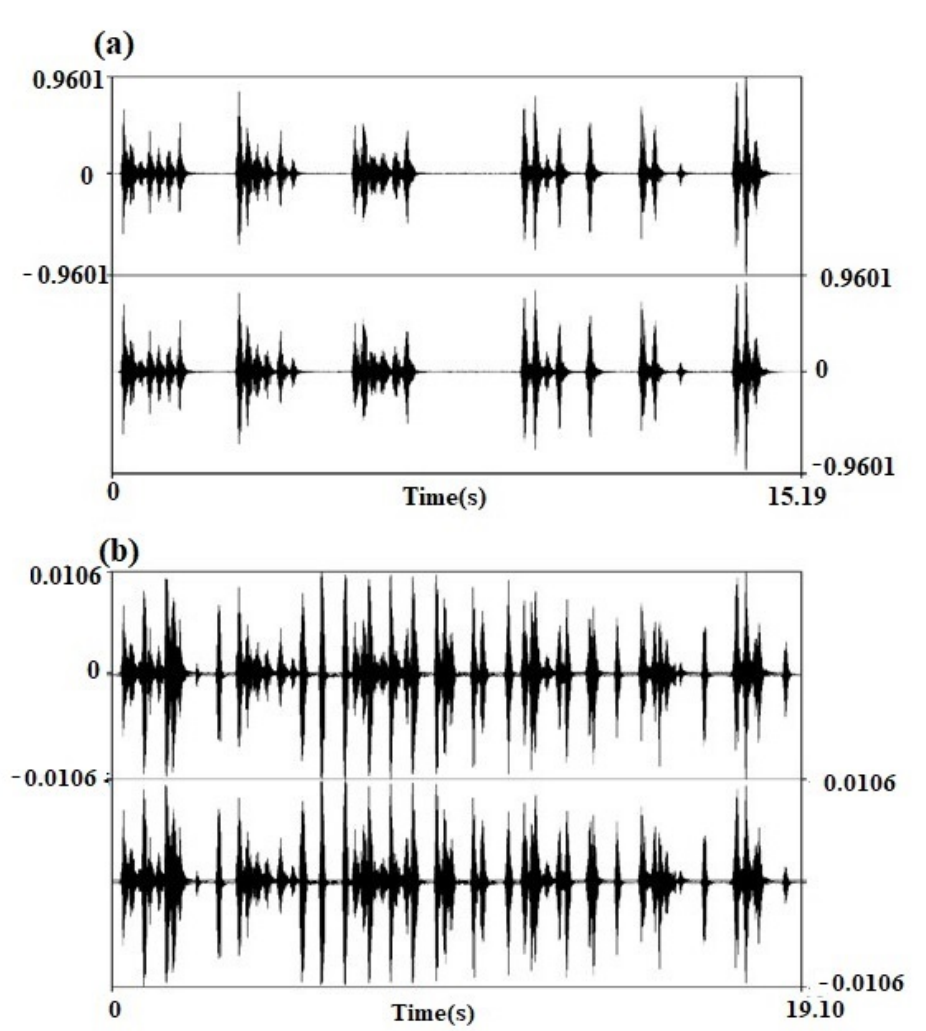
Figure 1. Spectrogram of dog sounds: ( a ) While Playing with Owner, ( b ) During Stranger Running.